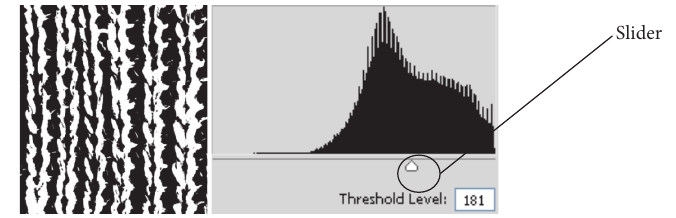
Figure 3: White mask image.